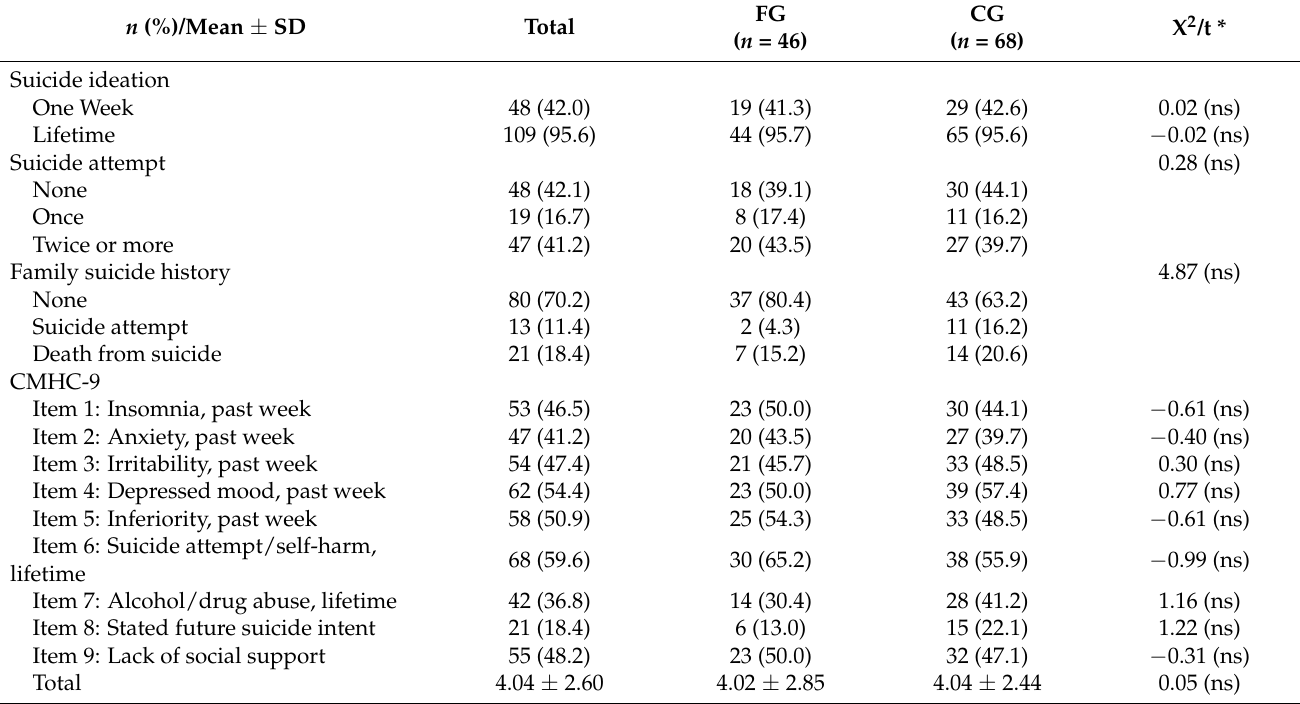
Table 2. Suicide risk factors of the participants at baseline